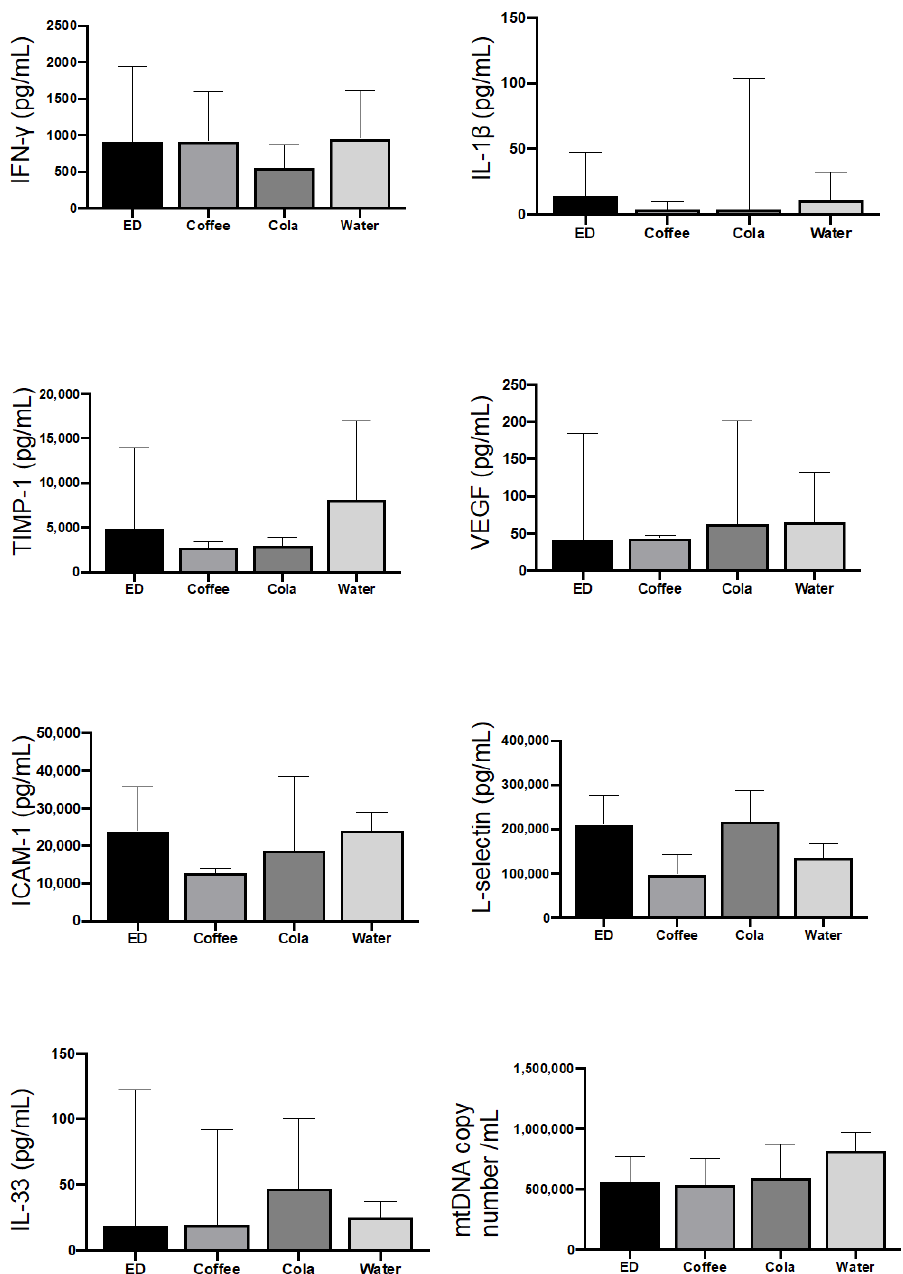
Figure 2. Caffeine does not induce systemic inflammation, despite eosinophilic reaction in the GI tract. Plasma levels of the indicated immunomodulatory molecules, as measured in rats after 5 days of caffeine administration. Concentrations are expressed as pg/mL, with the exception of mtDNA, which is expressed as number of copies per mL. Data are median ± interquartile range of seven samples, each in duplicate. ED = Energy Drink.